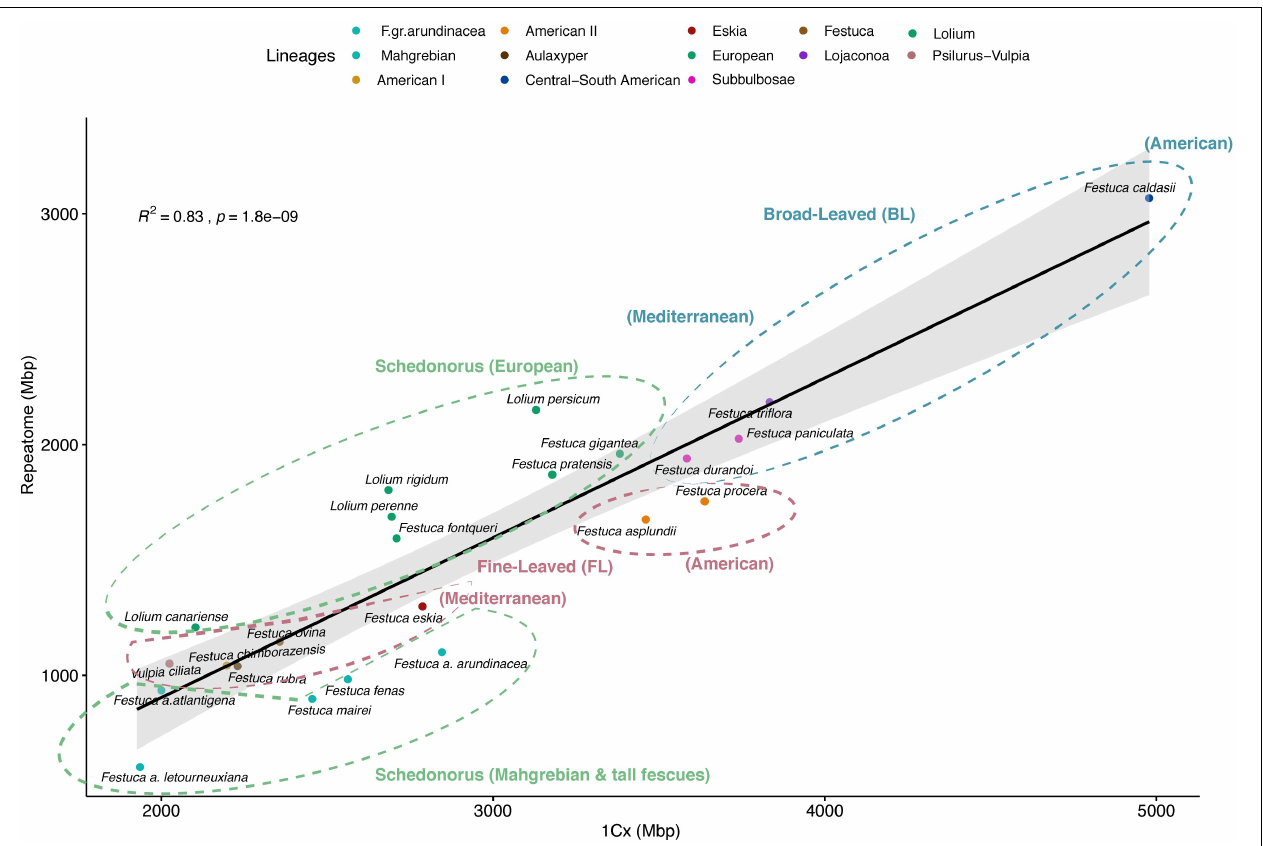
FIGURE 2 | Correlation plot of repeat content and genome size variation (1Cx) for the 23 Loliinae taxa with known genome sizes. Summed abundance values of the most represented repeat types obtained from the individual RE2 analysis. Pearson correlation analysis ( R 2 = 0.83, p = 1.8e–09). Ellipses with dashed lines encircle the main Loliinae groups and subgroups [broad-leaved Loliinae (BL), blue; Schedonorus, green; fine-leaved Loliinae (FL), magenta]. Color codes of Loliinae lineages correspond to those indicated in Figure 1